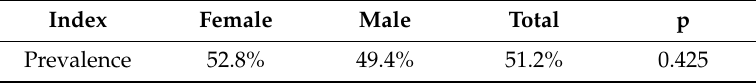
Table 1. The prevalence of bruxism among Vietnamese medical students.